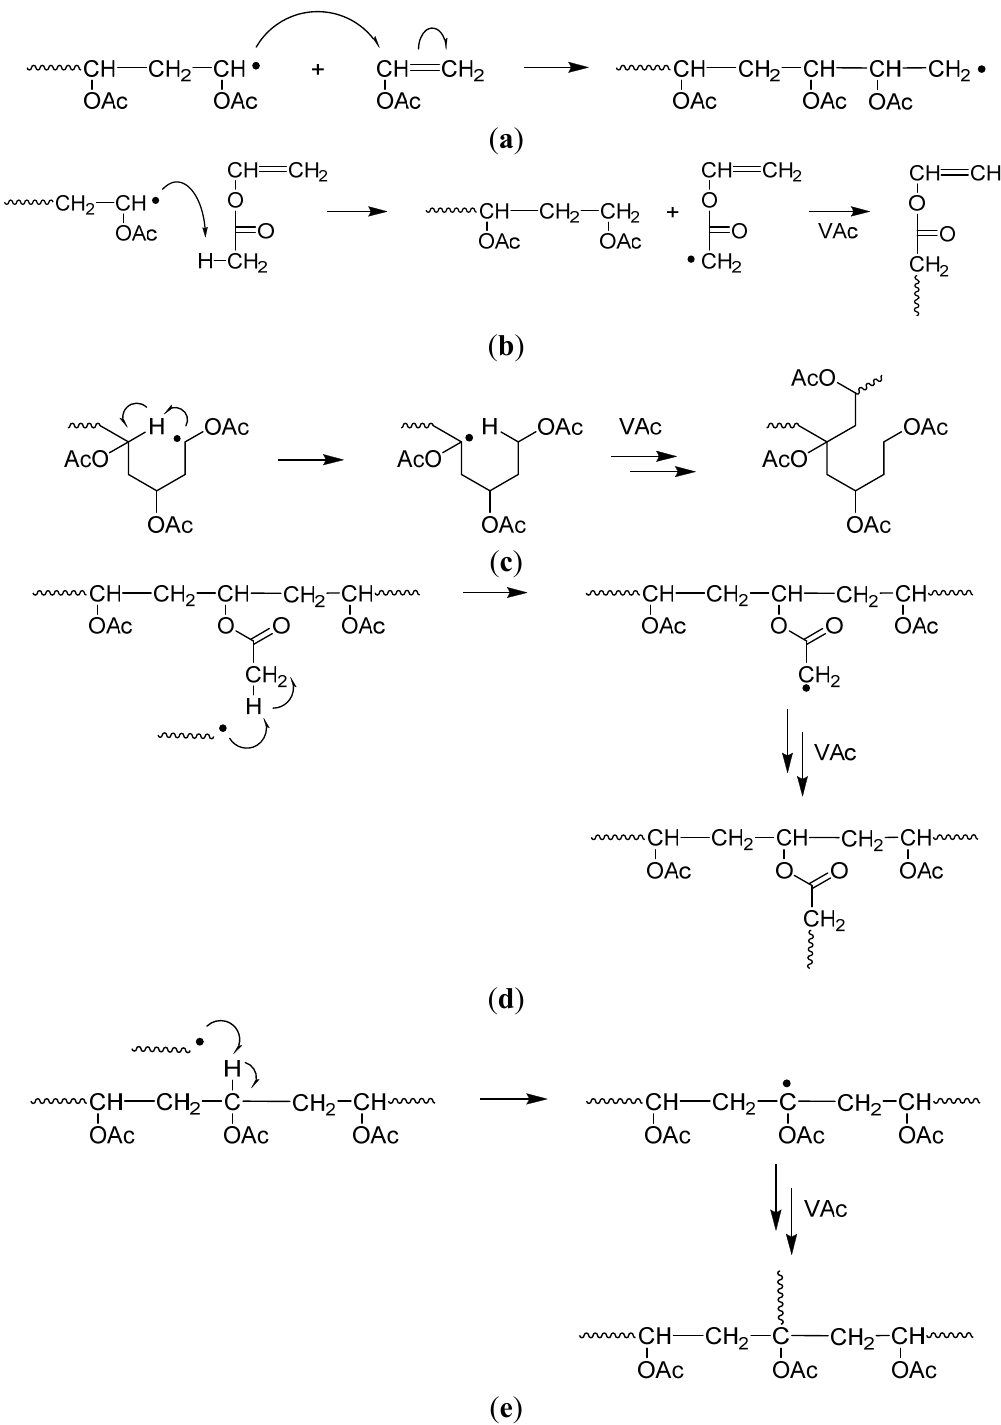
Scheme 1. Chain transfer reactions in polymerization of vinyl esters. ( a ) Head-to-head addition; ( b ) Chain transfer to monomer; ( c ) Intramolecular chain transfer to polymer (backbiting); ( d , e ) Intermolecular chain transfer to